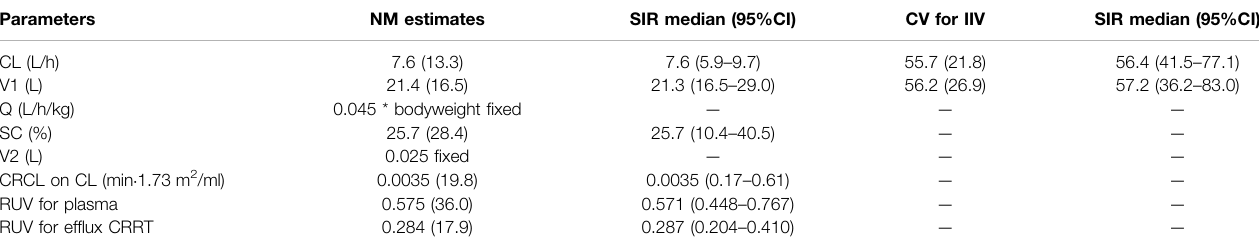
TABLE 4 | Final population PK parameter estimates of meropenem in septic children. Parameters